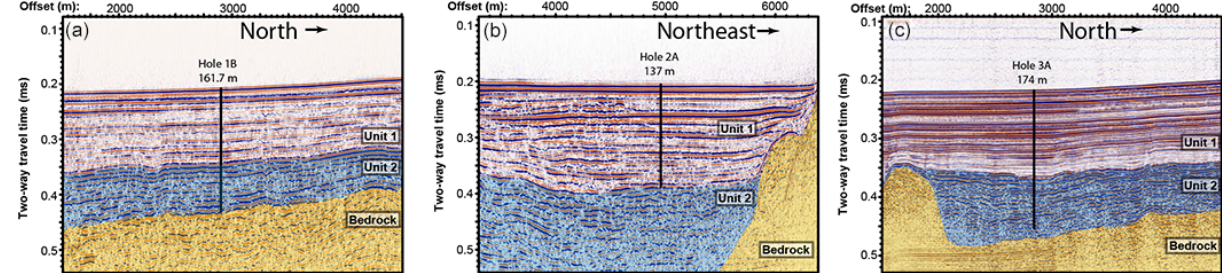
Figure 4. Expanded seismic reflection sections over the TDP core Sites 1 (a) , 2 (b) , and 3 (c) , with seismic Units 1 and 2, and bedrock labeled. Black lines show the positions and depths of TDP-TOW15-1B, TDP-TOW15-2A, and